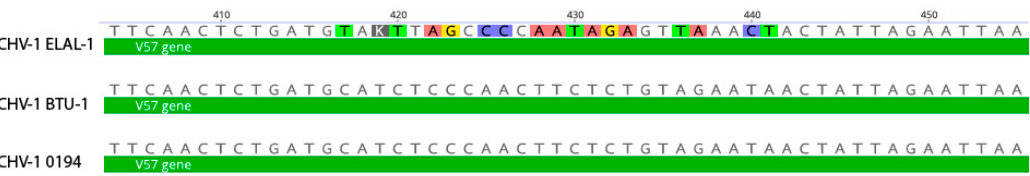
Figure 4. Variant in CHV-1 ELAL-1 isolate in the V57 gene region. A clearly identifiable region of low identity was detected centered around position 430 in the V57 gene which corresponded to a novel variant in CHV-1 ELAL-1.